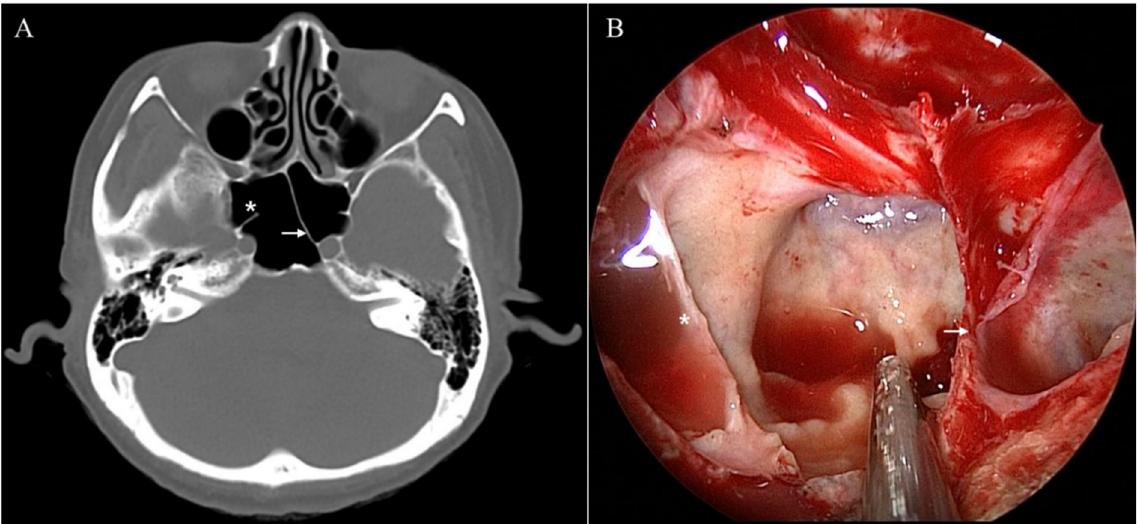
Fig 2. An intersphenoid sinus septum covering the paraclival internal carotid artery (asterisk) and entering that artery (arrow) in a patient with postsellar pneumatization, as revealed by preoperative paranasal sinus computed tomography (A) and during endoscopic endonasal transsphenoidal surgery